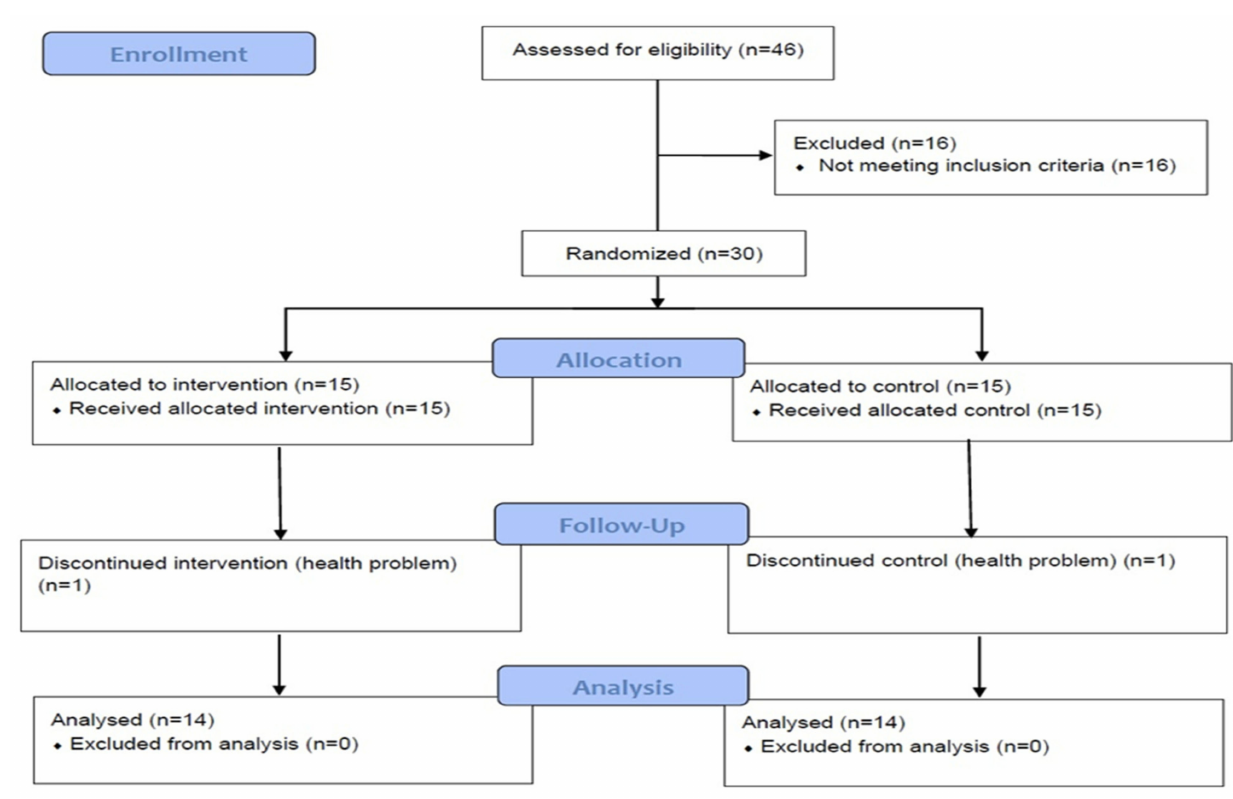
Figure 1. Participants’ flow diagram